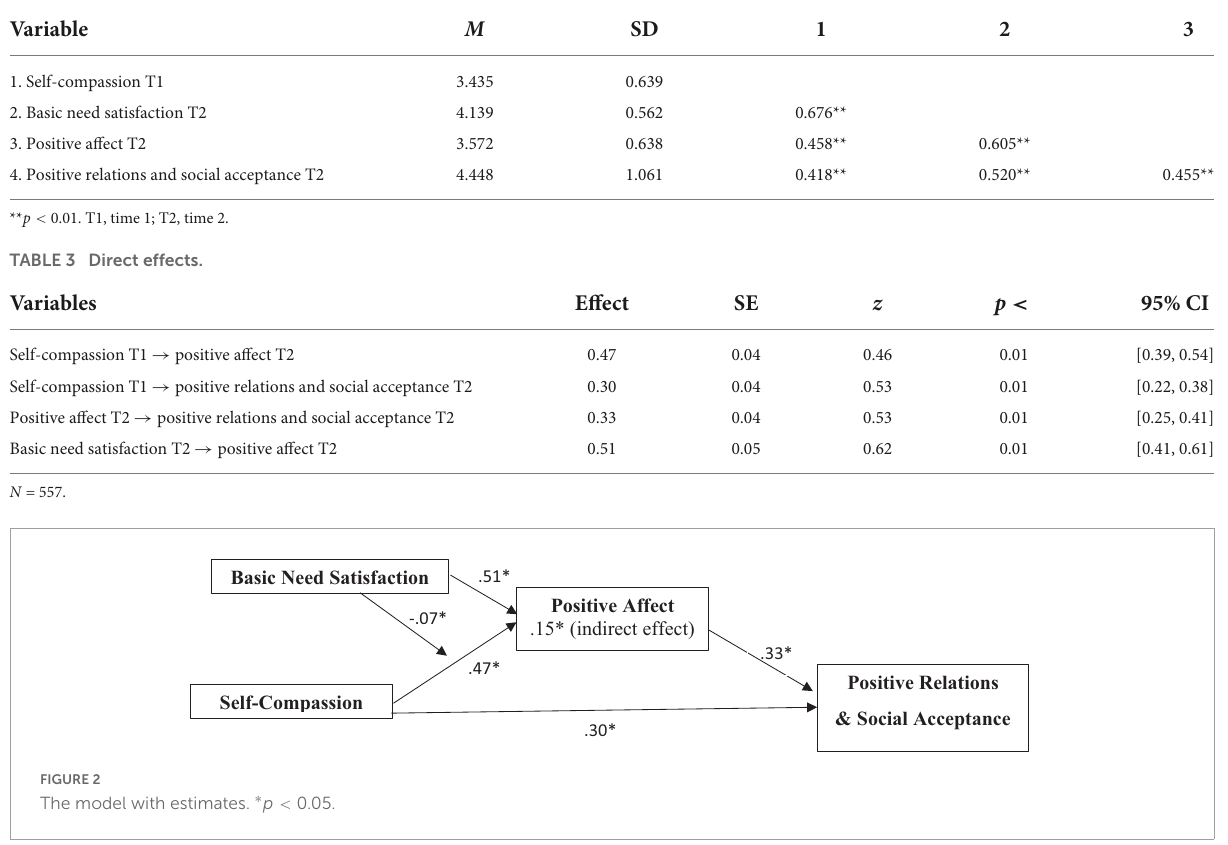
TABLE 2 Descriptive statistics and correlations.